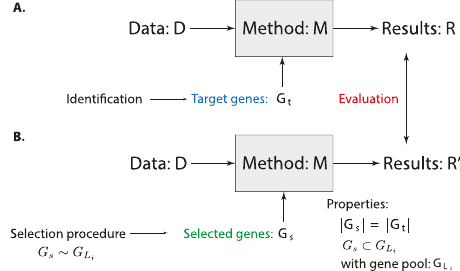
Fig. 5 Severe testing for selected genes. A Dependency of analysis results (R) on target genes G t . B Replication of the same analysis (with the same method M and data D ) by using selected genes, G s , . The results of both ( R and R 0 ) are compared for evaluating from G L i the effect of G s